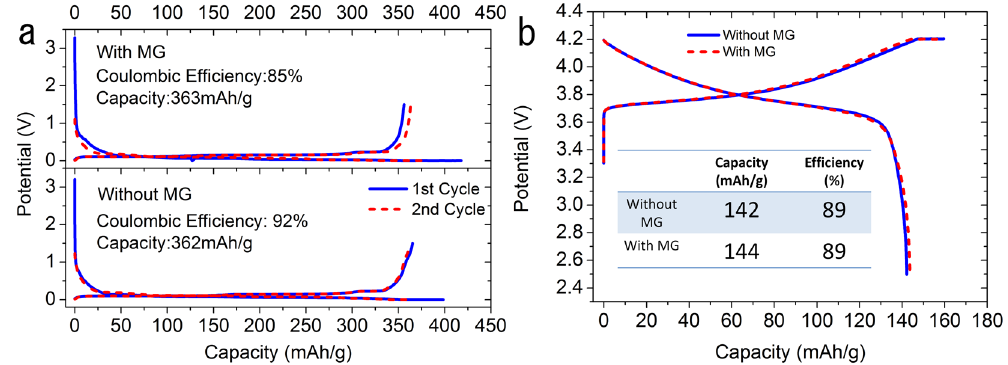
Figure 9. Half-cell initial charge and discharge curves of the reference cell and cell with MG: ( a ) graphite anode vs. lithium metal ( b ) NCM111 cathode vs. lithium